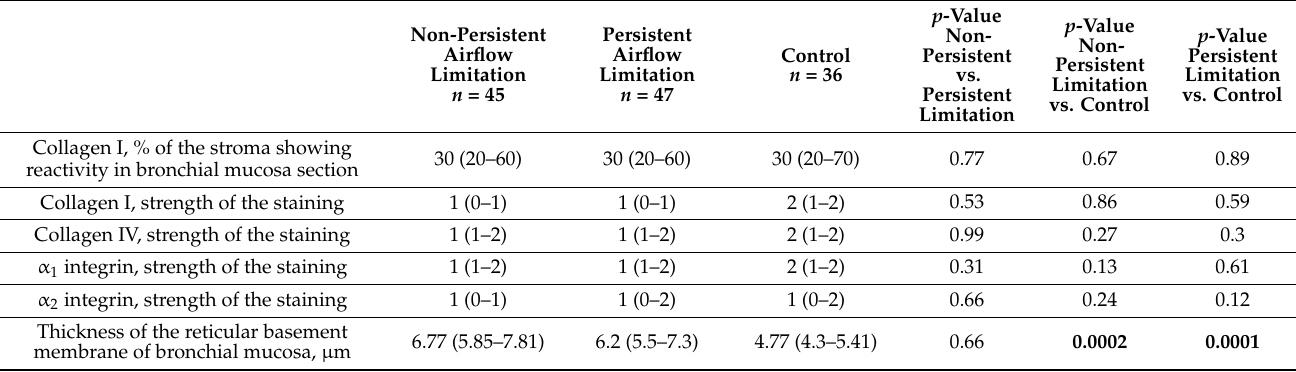
Table 3 footnote. Variables are presented as a median and interquartile range. The reticular basement membrane thickness was measured in n = 35 (78%) asthma patients with non-persistent airflow limitation, n = 36 (77%) of those with persistent airway obstruction,